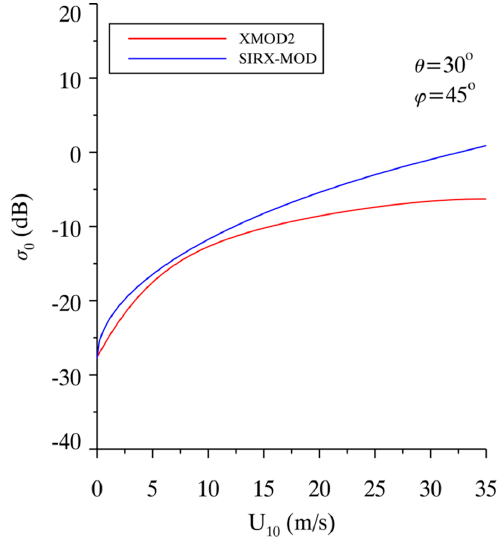
Figure 4. The simulation of XMOD2 and SIRX-MOD at θ of 30° and φ of 45°.